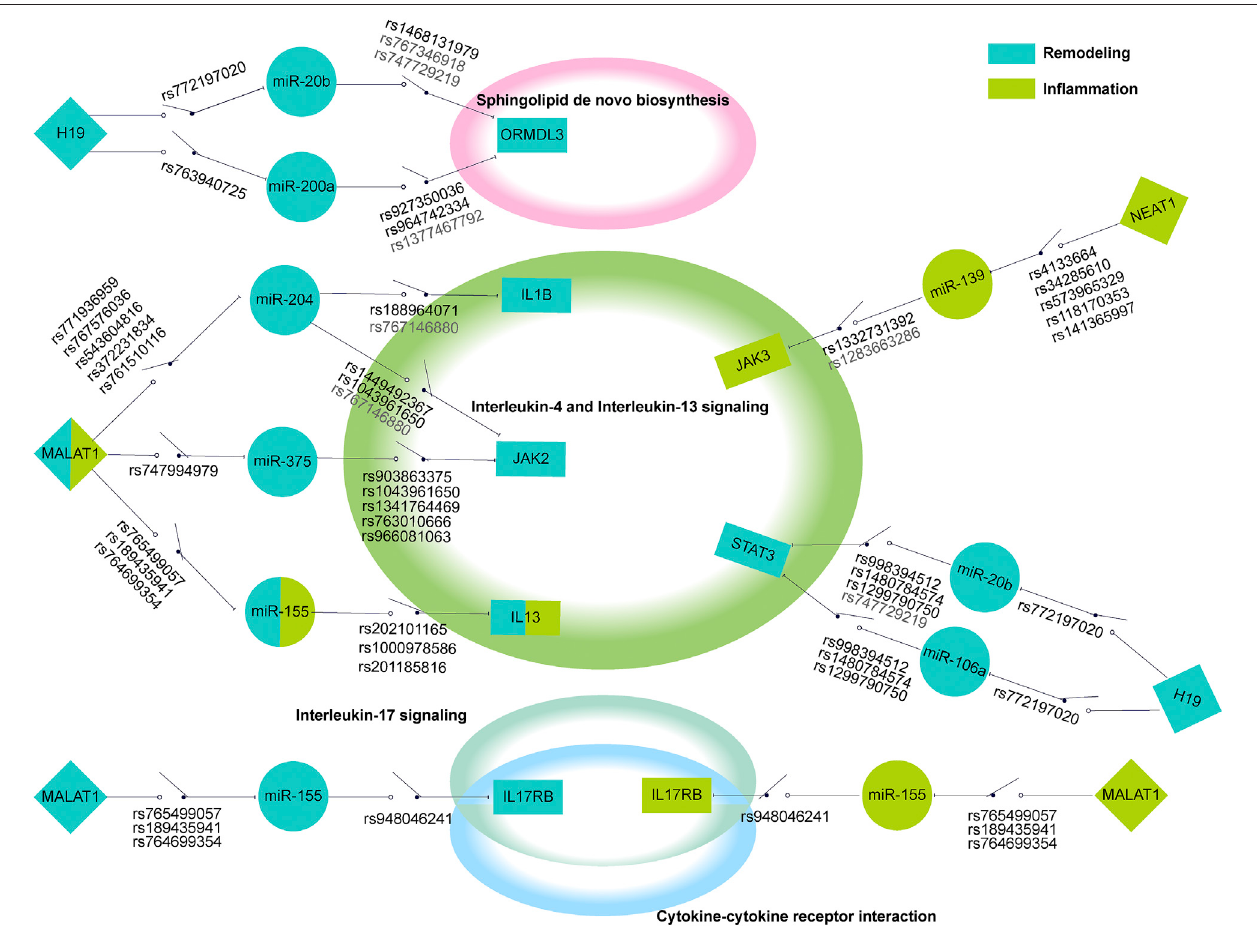
FIGURE5| TheschematicdiagramofregulatorySNPs → gene → pathwayeffectoffocusedgenes.Thegreenandbluerepresentedthegenesintheriskpathways concerning in fl ammation and remodeling respectively. The diamond, circle, and rectangle represent lncRNA, miRNA, and mRNA respectively. The line between them shows the regulation of ceRNA. The “ on-off ” symbol sited on line between lncRNA and miRNA or miRNA and mRNA indicate the regulatory SNP within the miRNA binding site on lncRNA or within the mature miRNA seed region (character colored in deep grey) or the 3 ′ UTR region (character colored in black). The peripheral large circles or rectangles denoted the pathways that regulatory SNPs may in fl uence through their effects on ceRNA regulations to target genes.